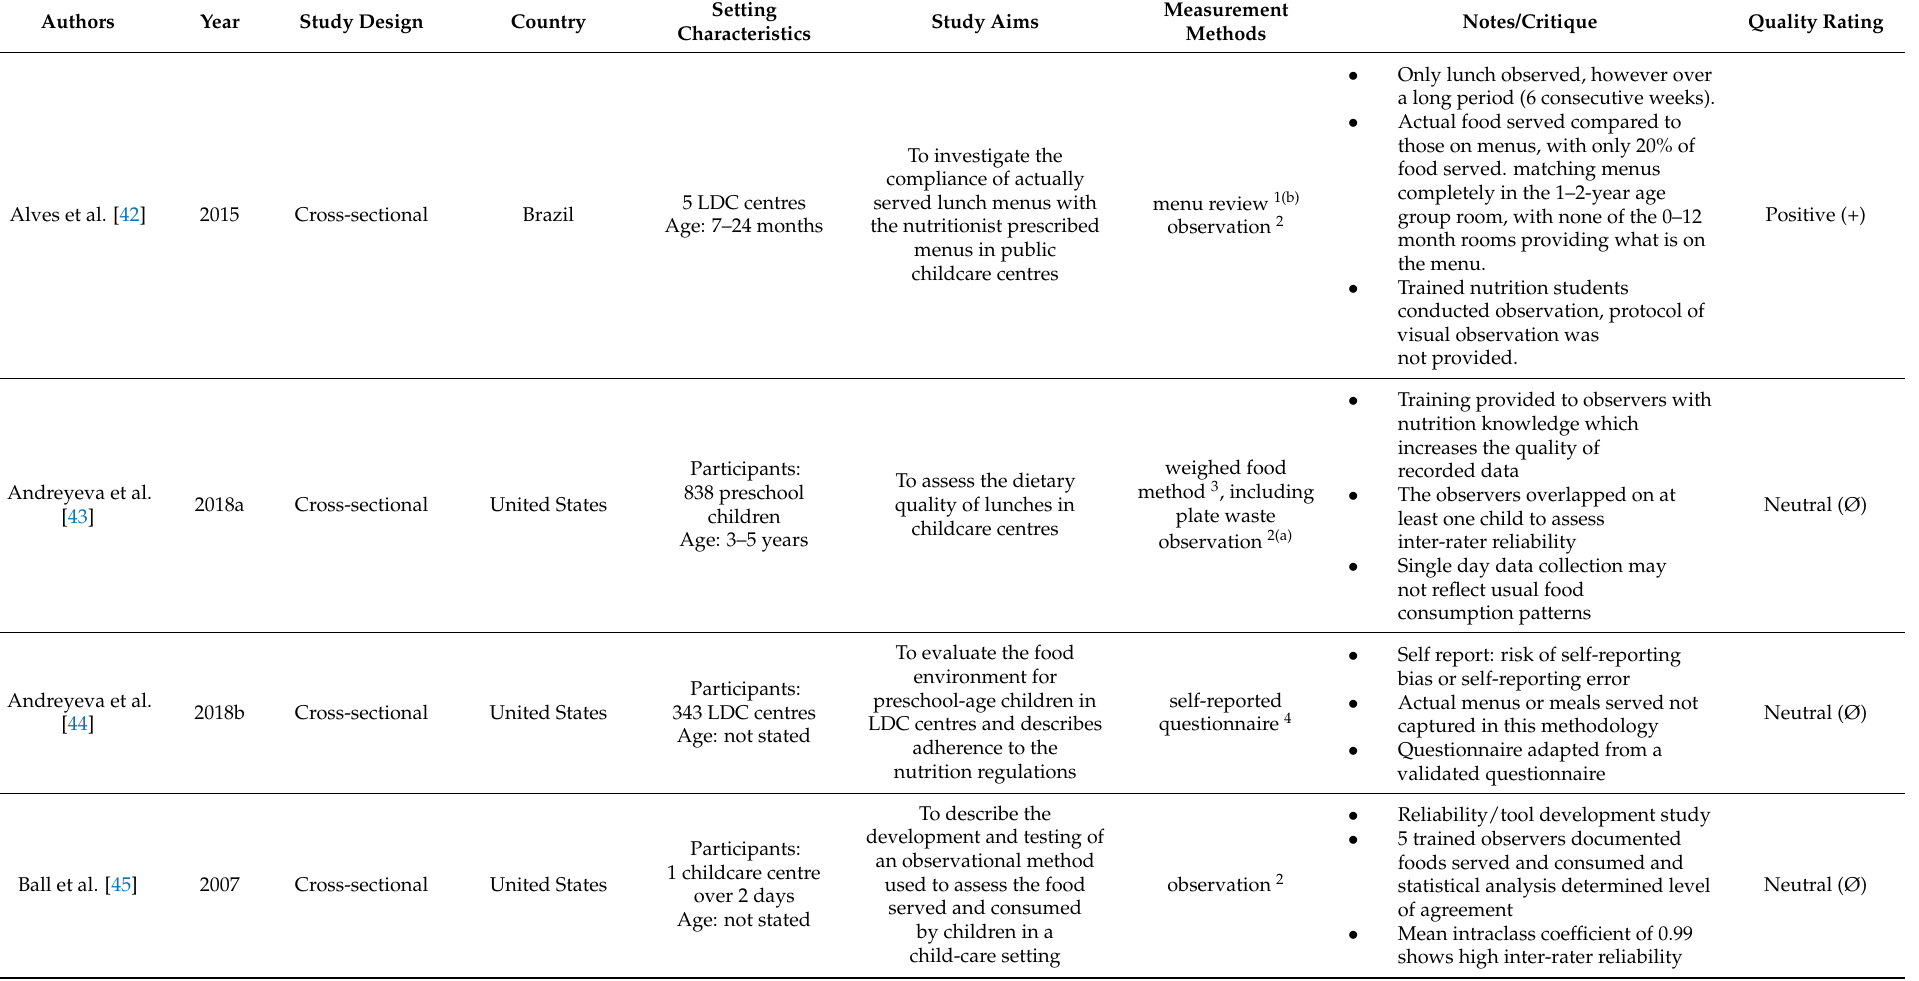
Table 1. Summary of studies measuring food provision in ECEC settings ( n =